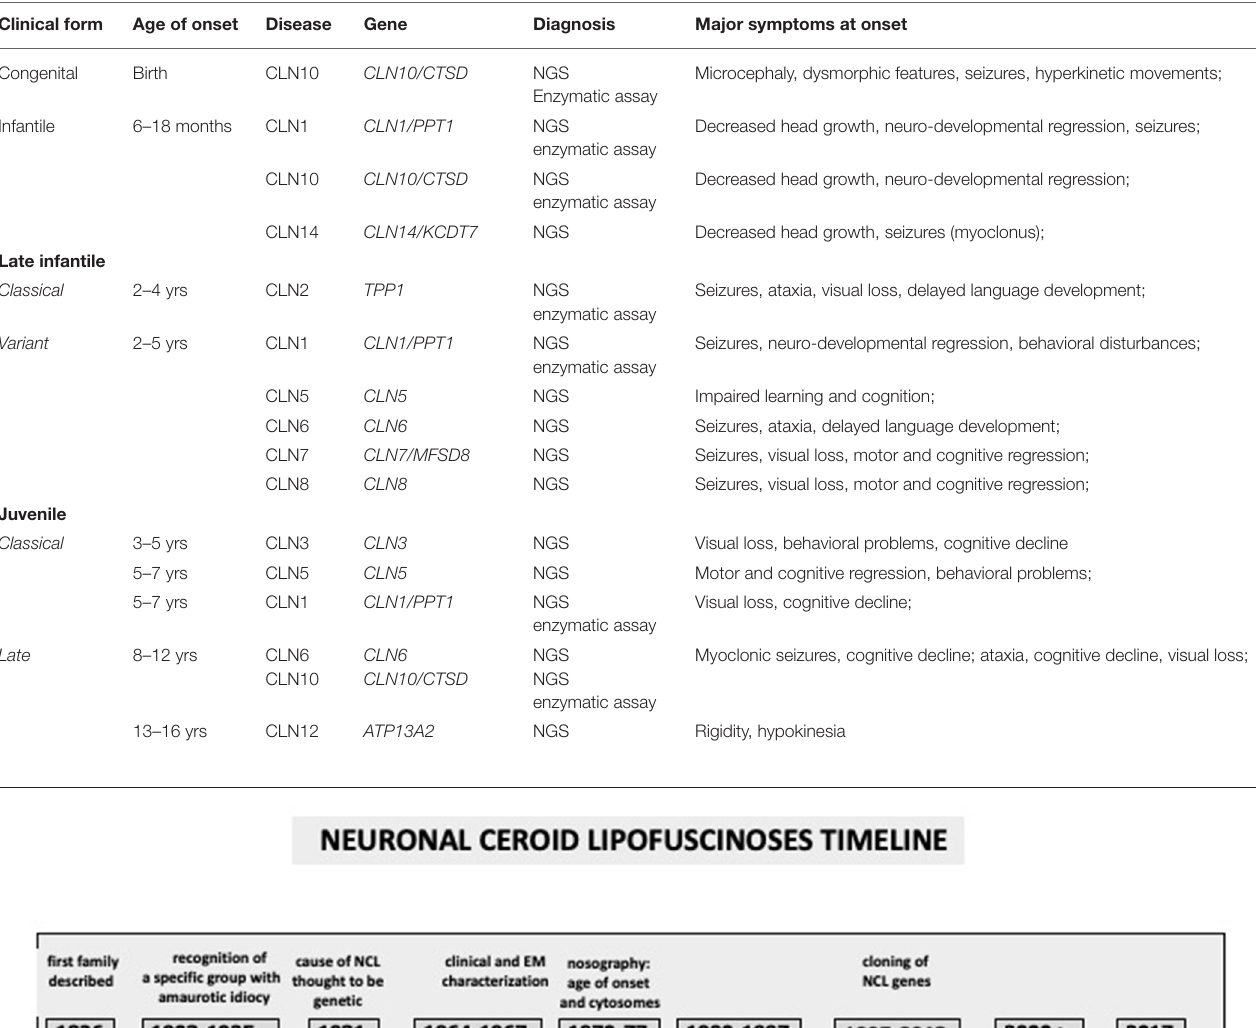
TABLE 1 | NCL of childhood onset: clinical classification and major diagnostic procedure. Clinical